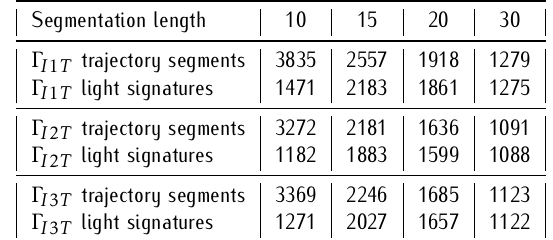
Table 6. Number of light intensity segments and unique light signatures with various segmentation lengths for Timis Deva trajectory (II) Similarities between measurements are captured in a trajectory specific data-set Φ saved in table 7.